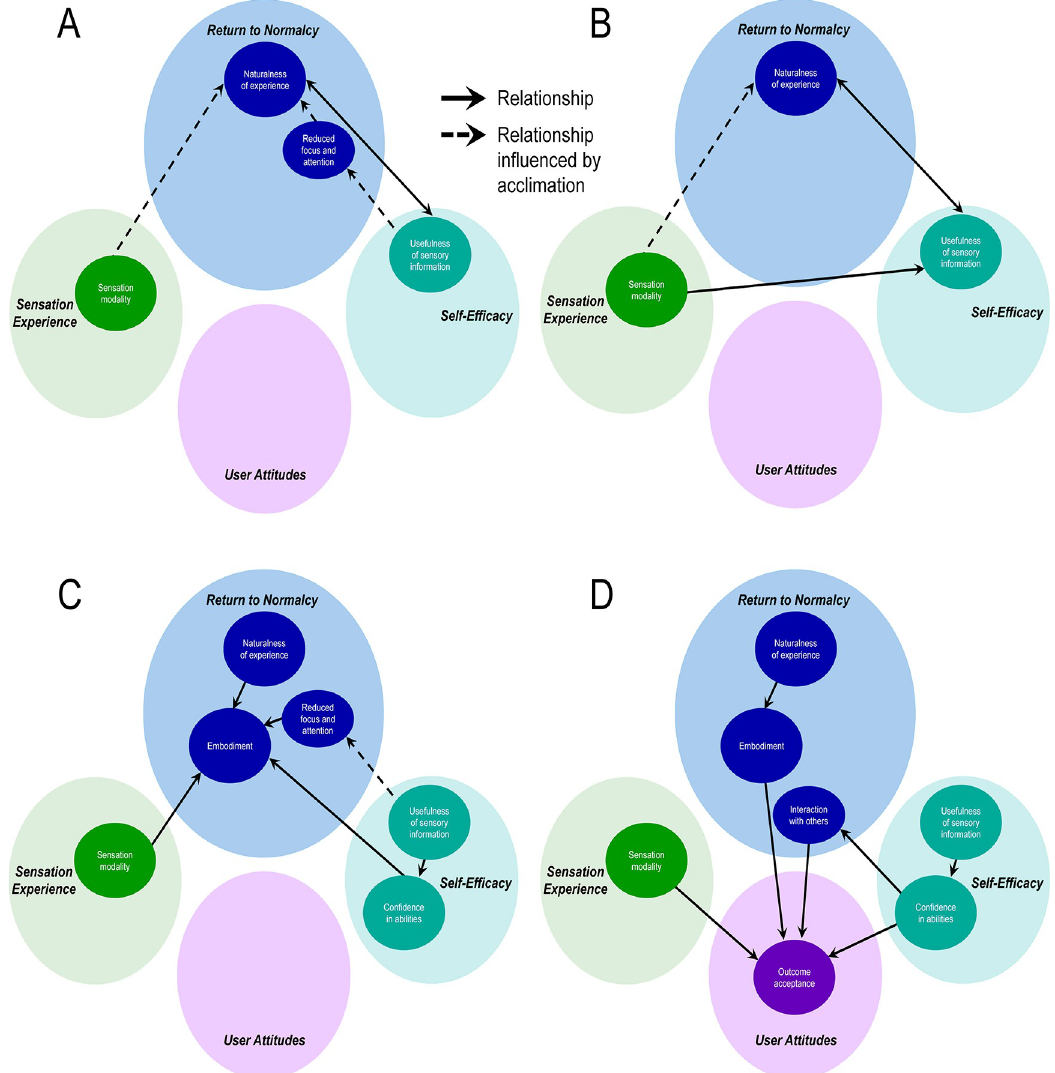
Fig 3. Concept relationships governing the benefits of sensation on the experience of a hand. A) Determinants of naturalness of experience. B) Determinants of usefulness of sensory information. C) Determinants of embodiment. D) Determinants of outcome acceptance. Solid arrows indicate directional relationships between concepts. Dashed arrows indicate relationships that are influenced by acclimation and thus strengthen over time.